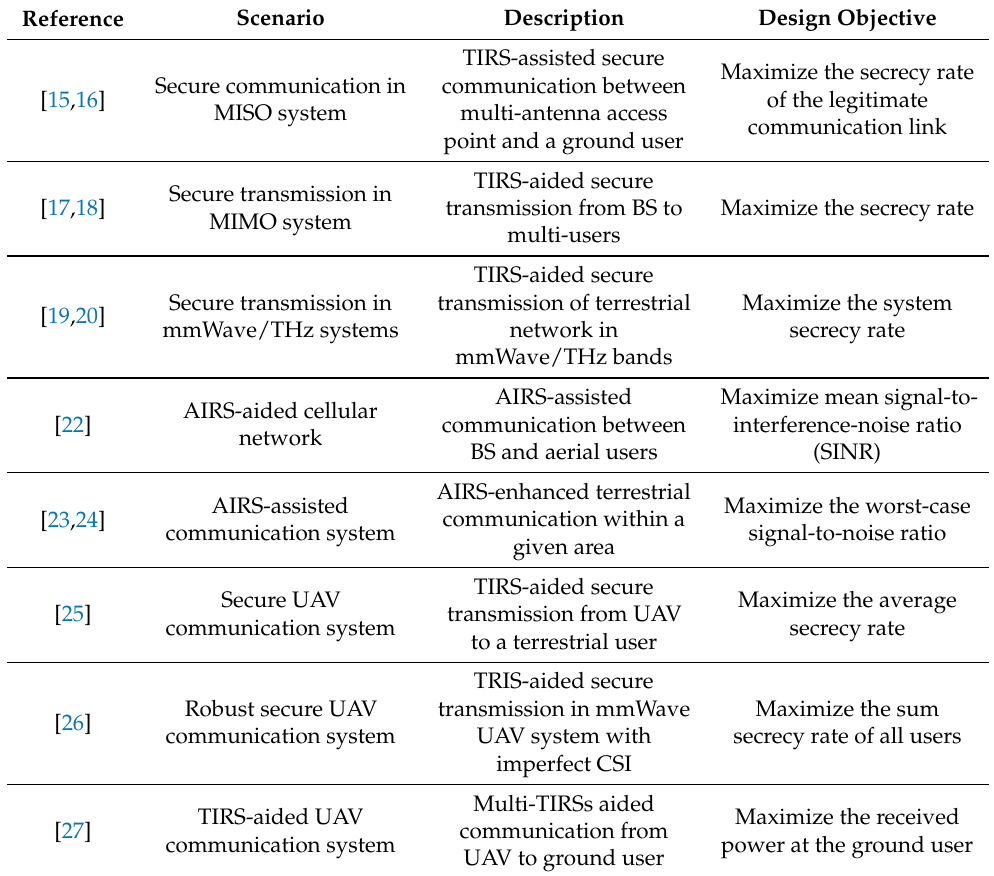
Table 1. Related work on IRS and UAV assisted